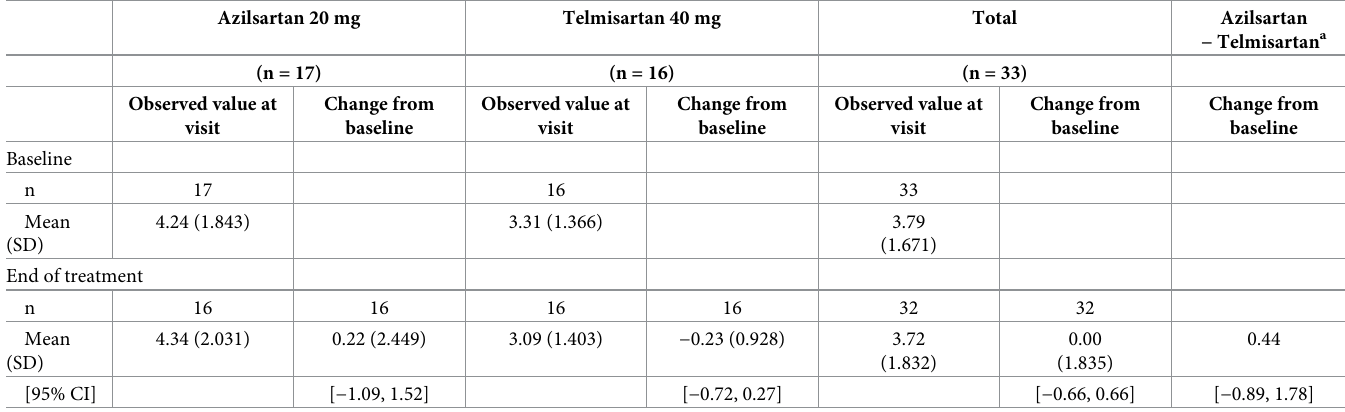
Table 2. Changes from the baseline values in HOMA-R at the end of the treatment period (FAS).